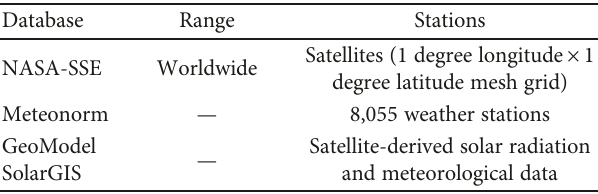
Table 2: List of meteorological databases consulted for the project.